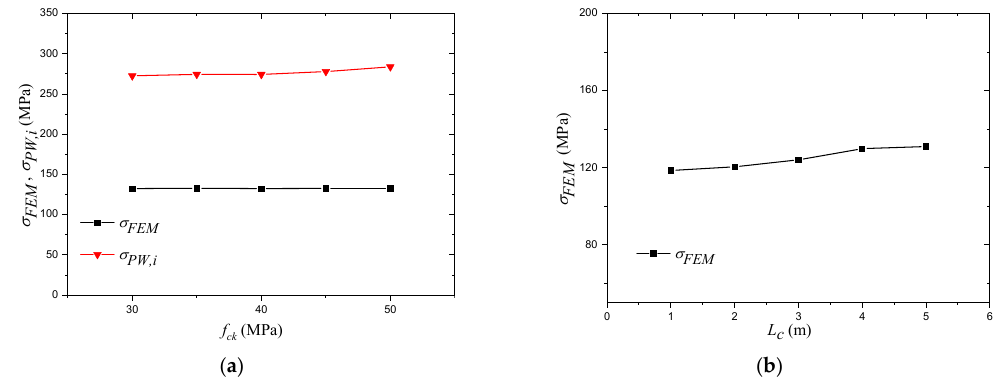
Figure 22. Parameters with small influence on the resultant stress of the welded corner. ( a ) Influence of concrete compressive strength ( f ck ); ( b ) Influence of the column height ( L c ).